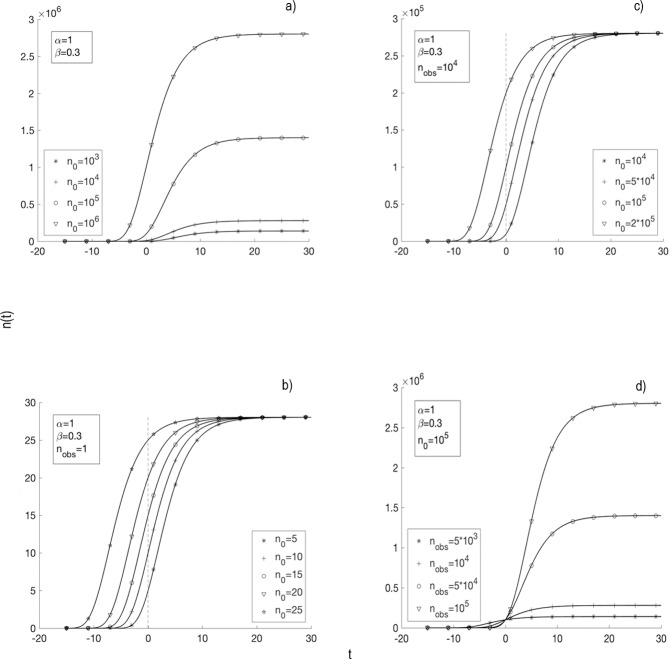
Evolution of the number of cells with time.Simulation of the number of cells at time t, in days, (n (t)) for α = 1.0 days-1 and β = 0.3 days-1. (A) Simulation of GE2 for different values of n0 (1x103, 1x104, 1x105 and 1x106 cells). (B) Simulation of GE8 for nobs = 1 cell (coincides with GE5) and different values of n00 = n0 (5, 10, 15, 20 and 25 cells). (C) Simulation of GE8 for nobs = 1x104 cells and different values of n000 = n0 (1x104, 5x104, 1x105 and 2x105 cells). (D) Simulation of GE8 for n000 = n0 = 1x105 cells and different values of nobs (5x103, 1x104, 5x104 and 1x105 cells).